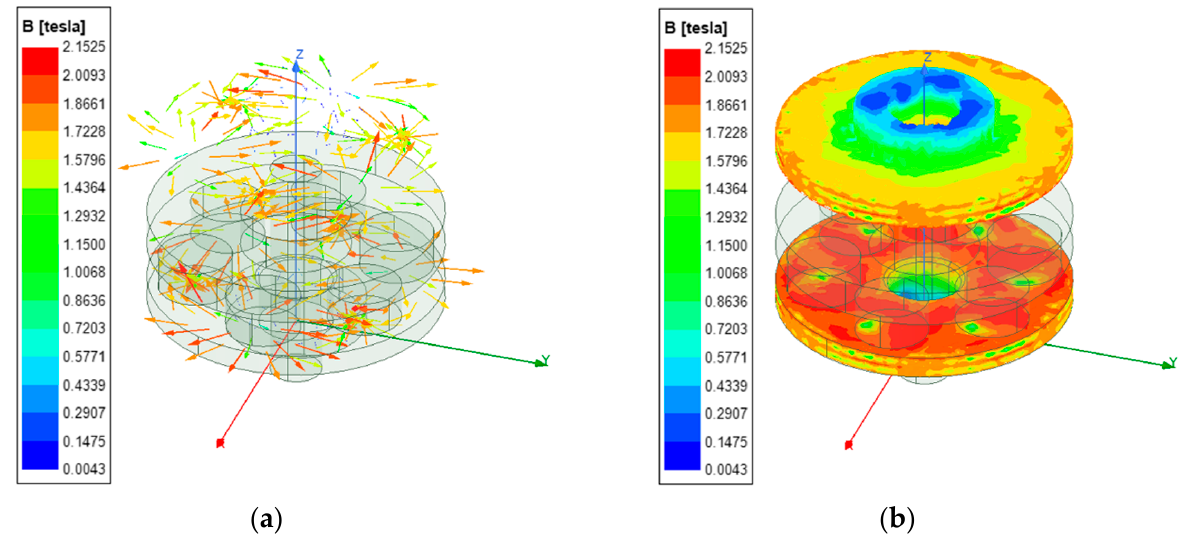
Figure 14. Transient magnetic flux density distribution of the rotor disks: ( a ) Vector distribution; ( b ) Field distribution.